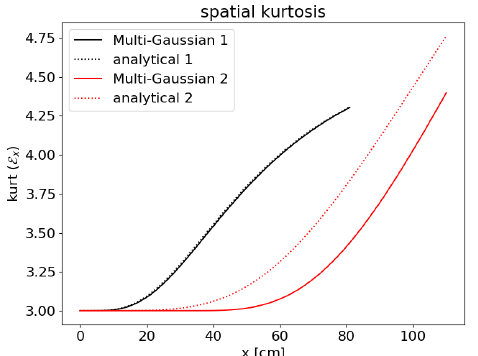
Figure 3. Evolution of the spatial kurtosis kurt( E x ) of the beam along the propagation axis x = τ . Comparison of the multi- Gaussian solution (26) and the analytical reference for two sets of fluctuation parameters. Parameters cf. fig.